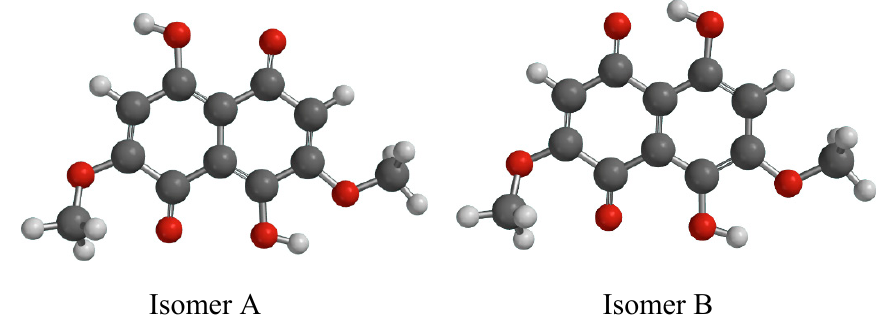
Figure 5. Nuclear Magnetic Resonance (NMR) proposed structures.